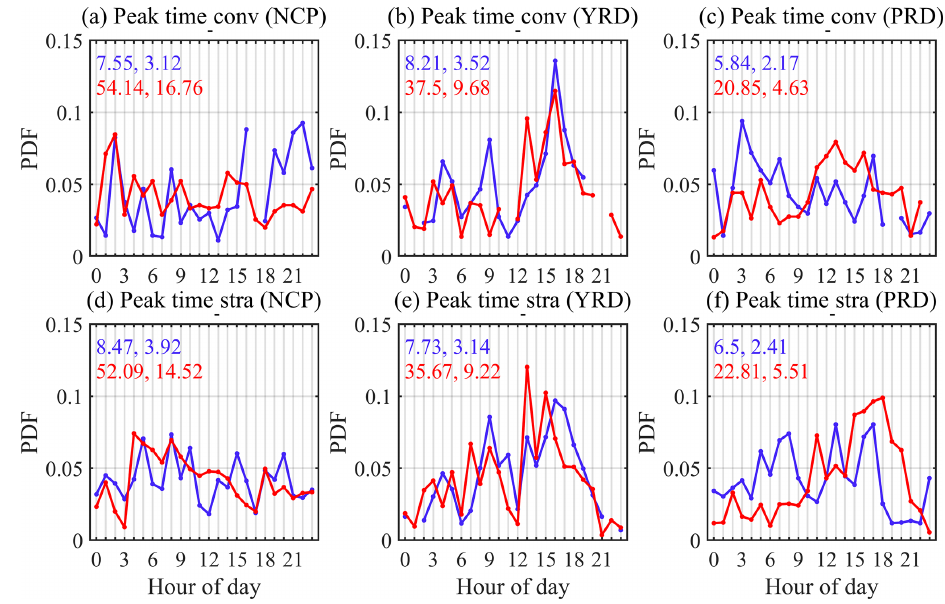
Figure 8. Same as Fig. 7, but for (a) – (c) convective precipitation peak time and (d) – (f) stratiform precipitation peak time (LT).